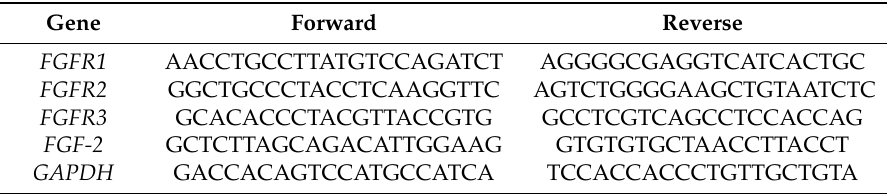
Table 1. Sequences of the primers used for the real-time polymerase chain reaction.